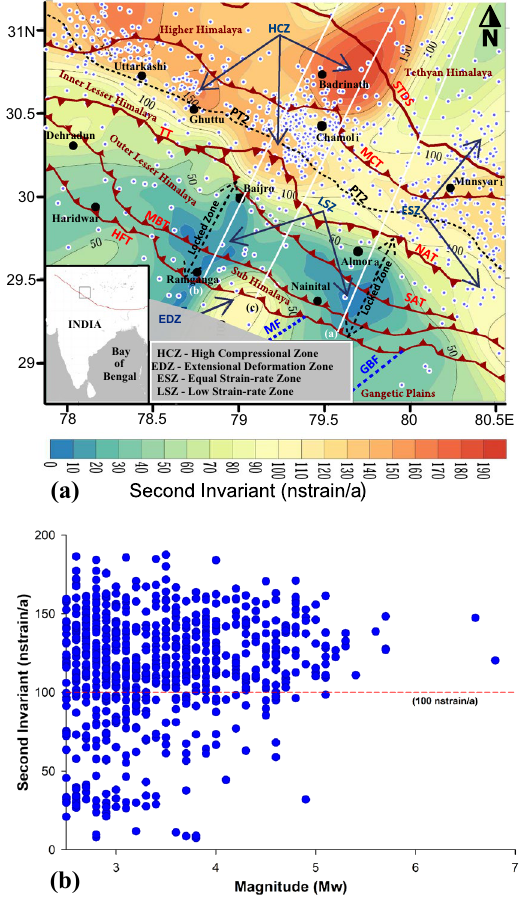
Figure 4. (a) Second invariant strain map of the Garhwal–Kumaun Himalaya. Coloured contours represent the total strain rates in the region as a scalar quantity. High compression zone (HCZ), Extensional deformational zone (EDZ), Equal strain-rate zone (ESZ), Low strain-rate zone (LSZ), and the locked zone are marked. Three profiles are plotted in the figure and their explanations are given in Fig. 5. The black rectangle given in the inset map at the left bottom corner of the plot indicates the study area. The base map was created using the Surfer software (https:// www. golde nsoft ware. com/ produ cts/ surfer) and further modifications are done in Grapher software (https:// www. golde nsoft ware. com/ produ cts/ graph er). ( b ) Second invariant of strain-rate above and below the 100 nstrain/a barrier is plotted against the earthquake